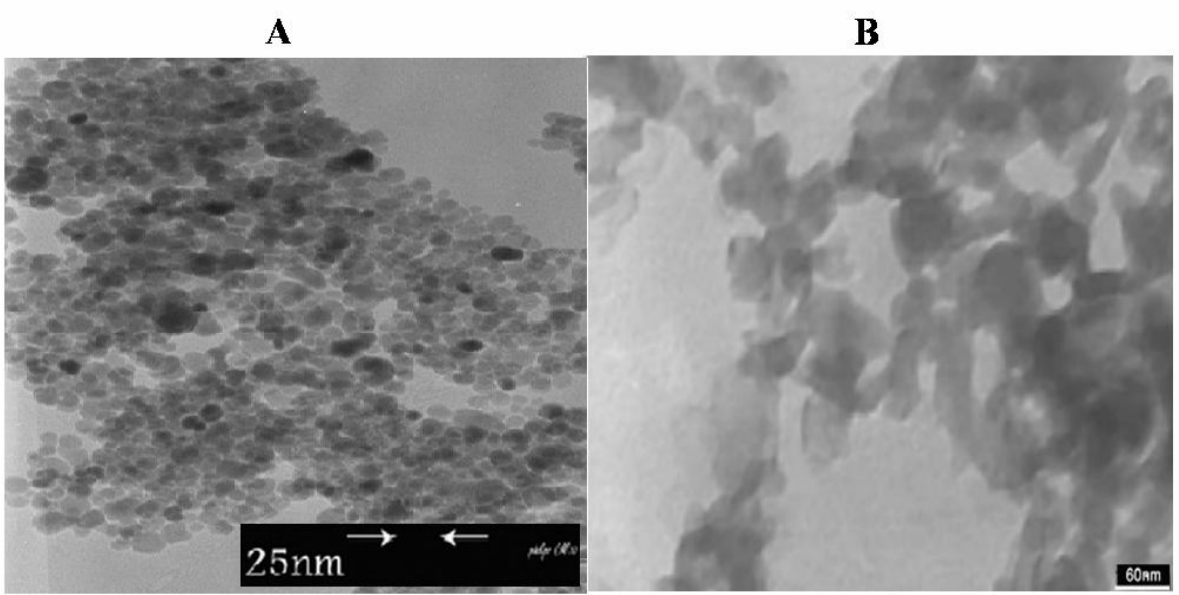
Fig. 4. TEM images of (A) MNPs, (B) Si-Im-HSO